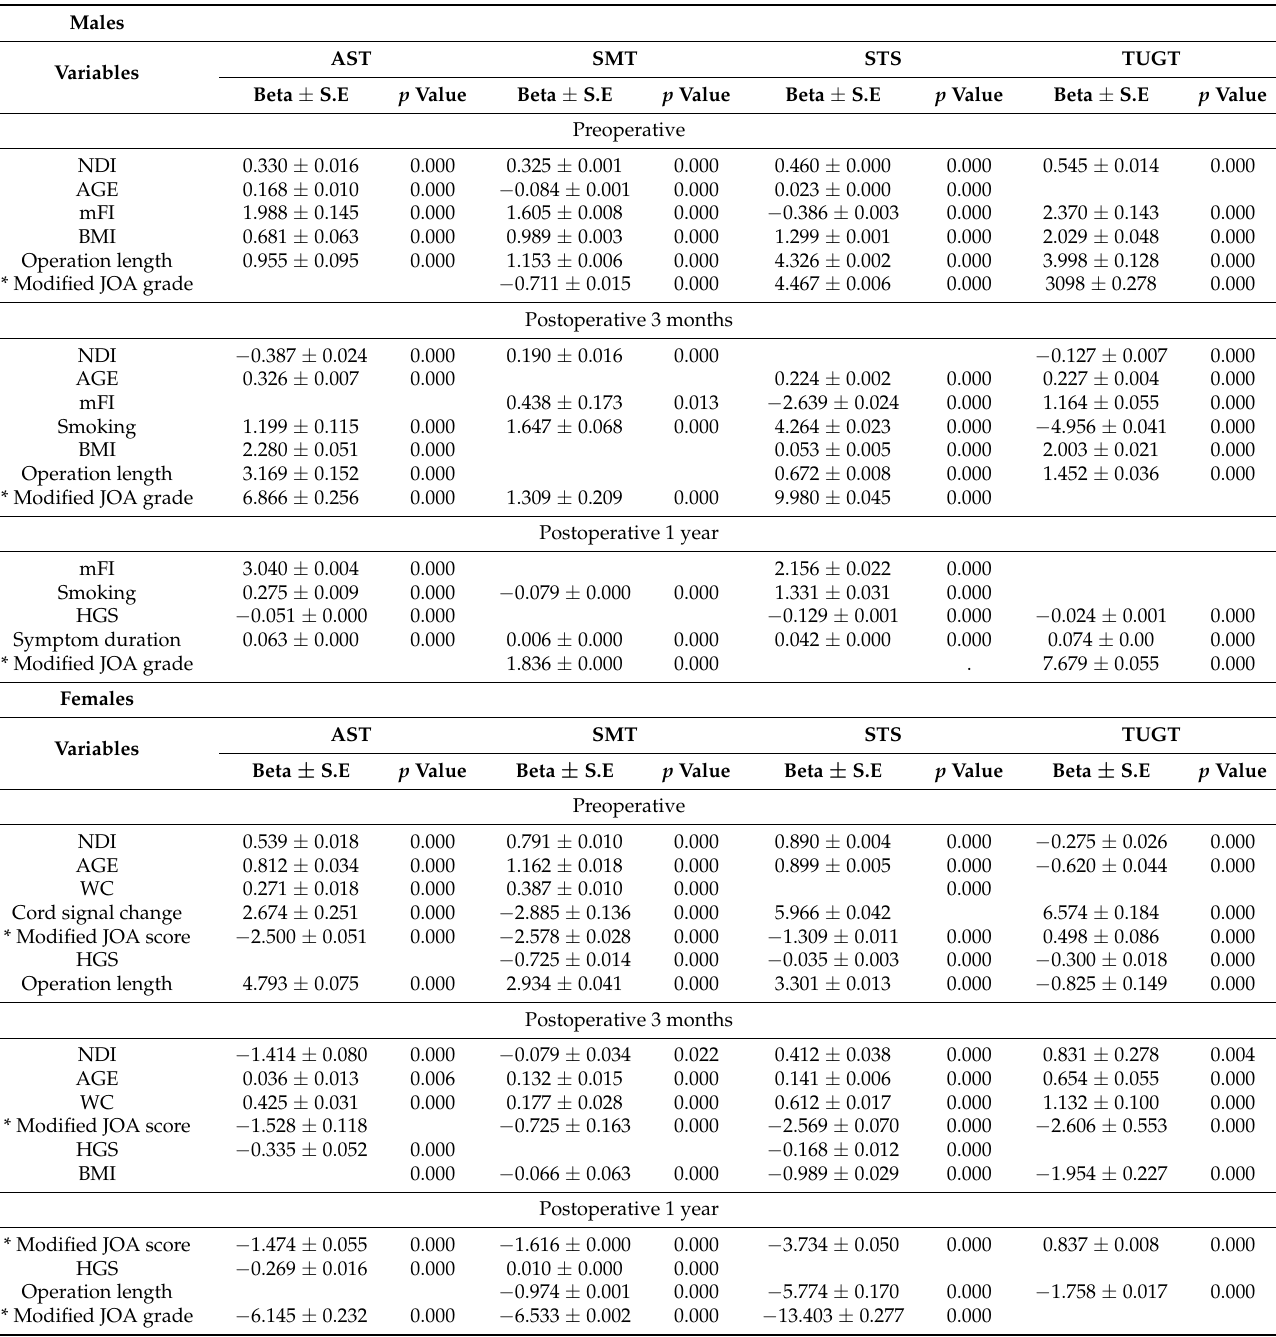
Table 5. Multiple regression analyses of fall-related functional mobility